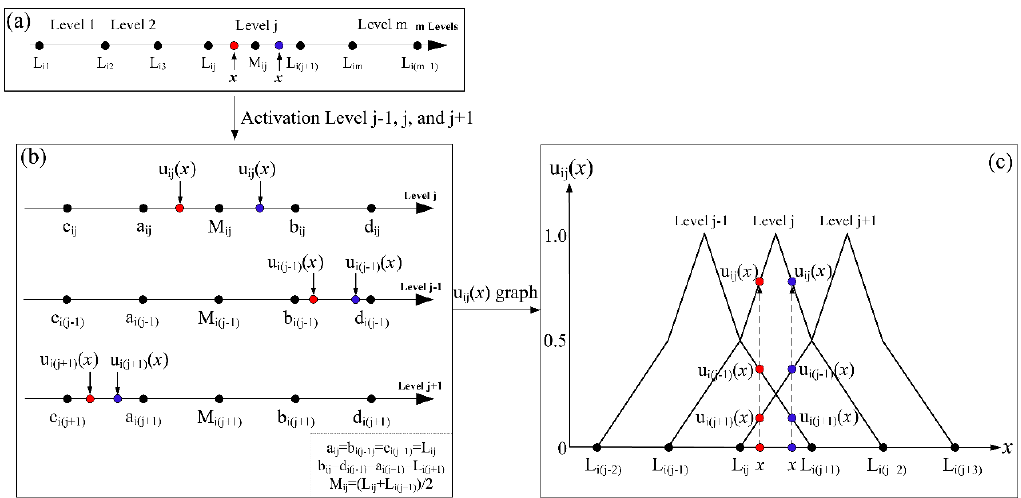
Figure 4. ( a ) The linear relationship between measured value 𝑥 and standard value 𝐿 𝑖𝑗 ; ( b ) the linear relationship between 𝑥 and the VFS model parameters c, a, M, b, and d on activation levels j, j – 1, and j + 1; ( c ) the position of the RMD value corresponding to x on the RMD function of activation levels j, j – 1, and j + 1.